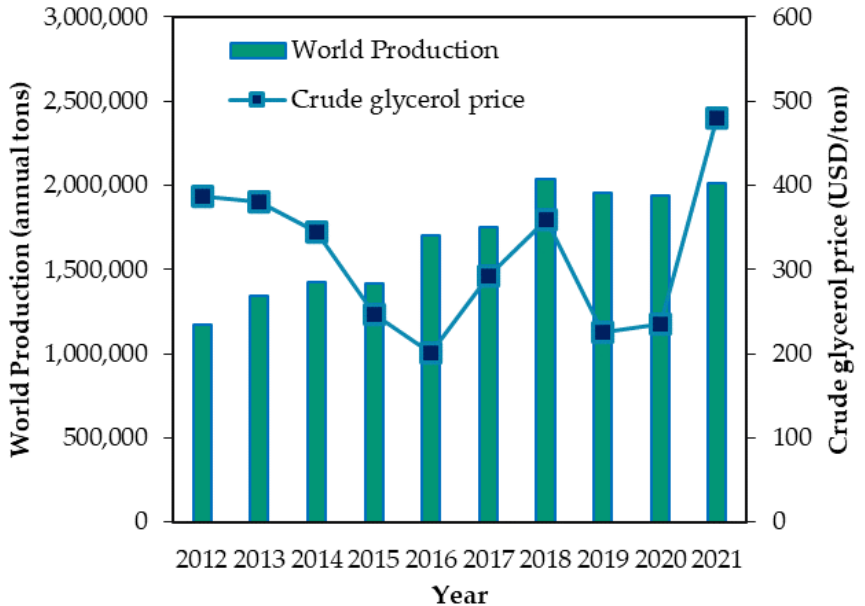
Figure 2. The annual crude glycerol production and market price (2012 – 2021).